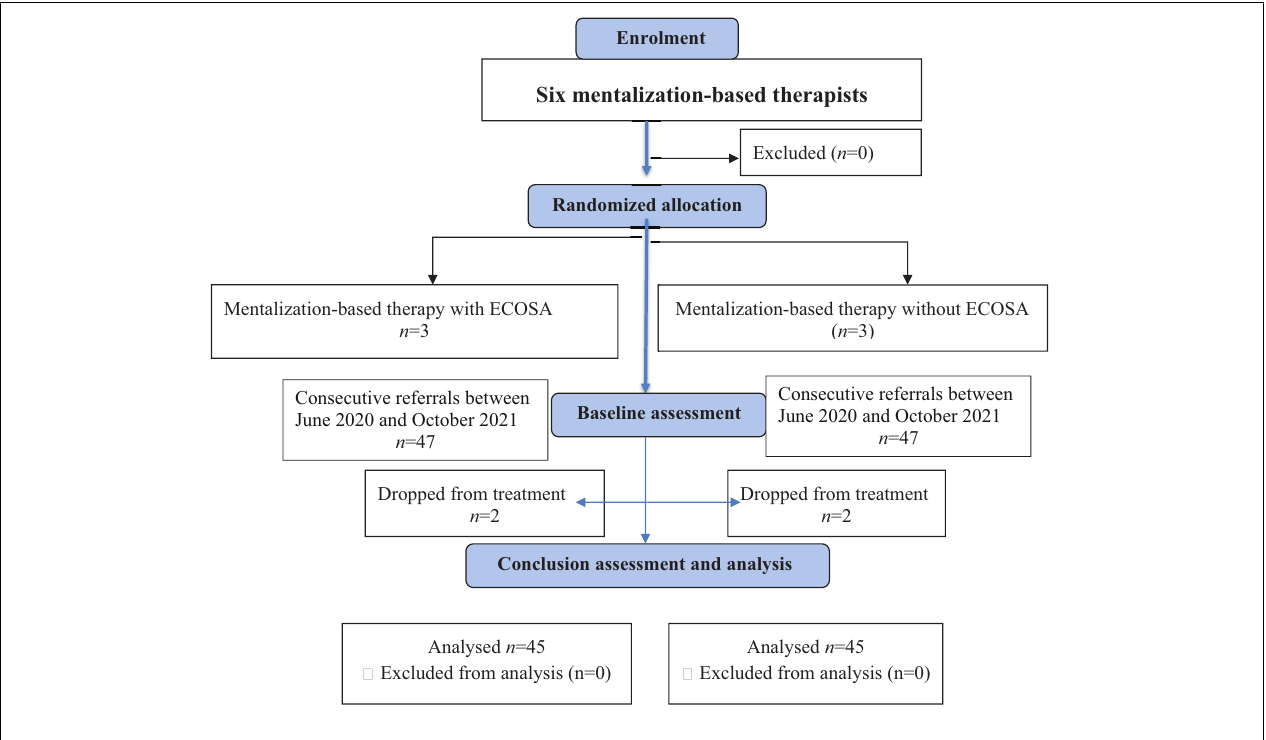
FIGURE 2 | Study flow